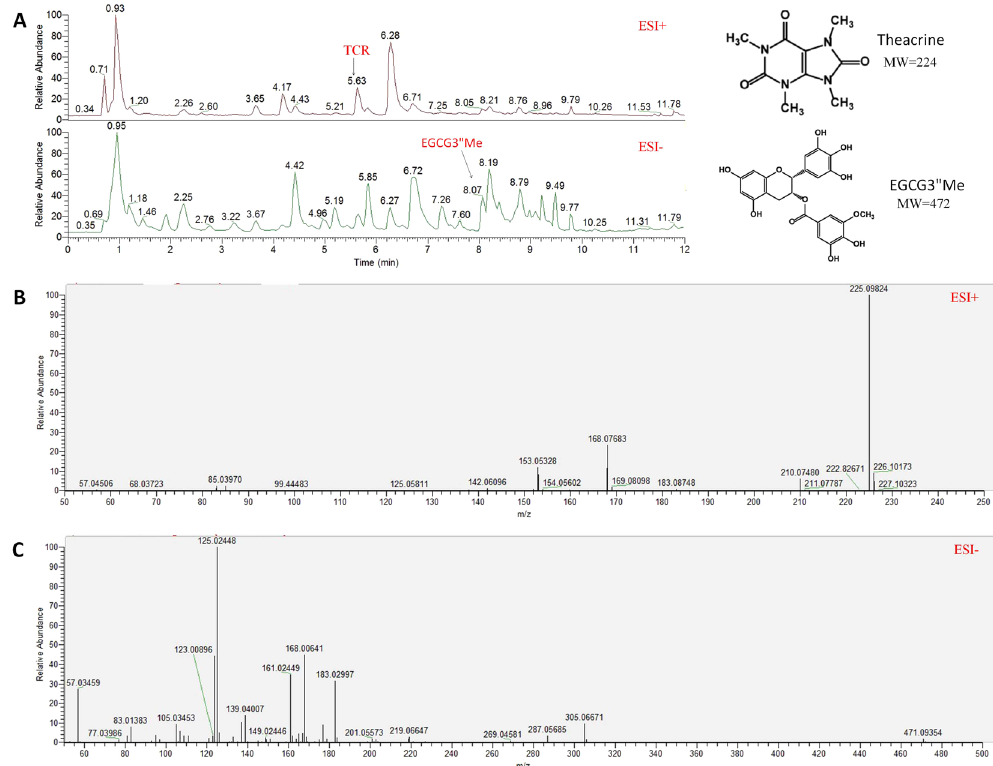
Figure 4. Total ion current (TIC) chromatograms and fragment ions of two compounds. ( A ) TIC of a typical Baiyacha plant in the ESI − and ESI + mode, ( B ) fragment ions of theacrine in the ESI + mode, ( C ) fragment ions of EGCG3 ″ Me in the ESI −